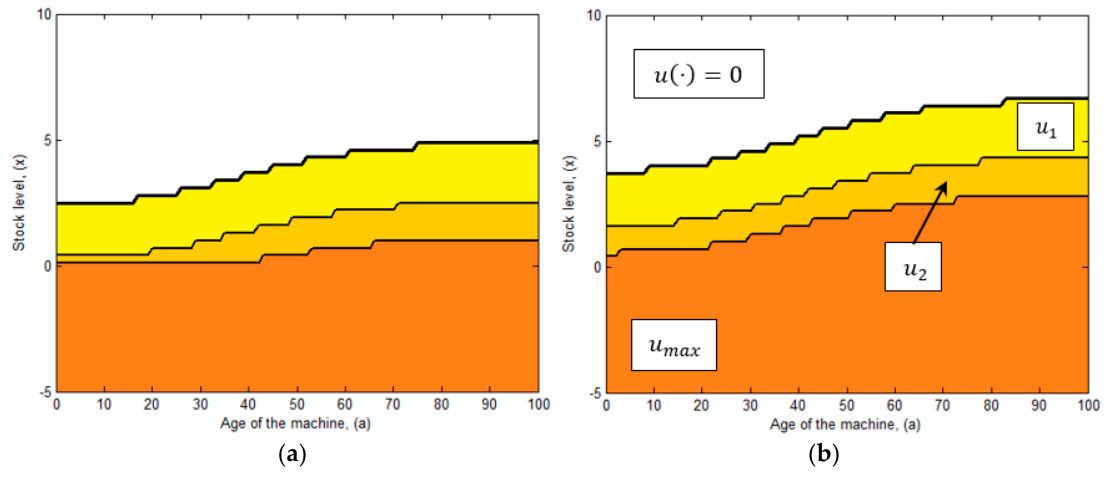
Figure 7. Sensitivity of the backlog cost on the production policy. ( a ) (cid:1855) (cid:2879) = 50 ; ( b ) (cid:1855) (cid:2879) = 250 .